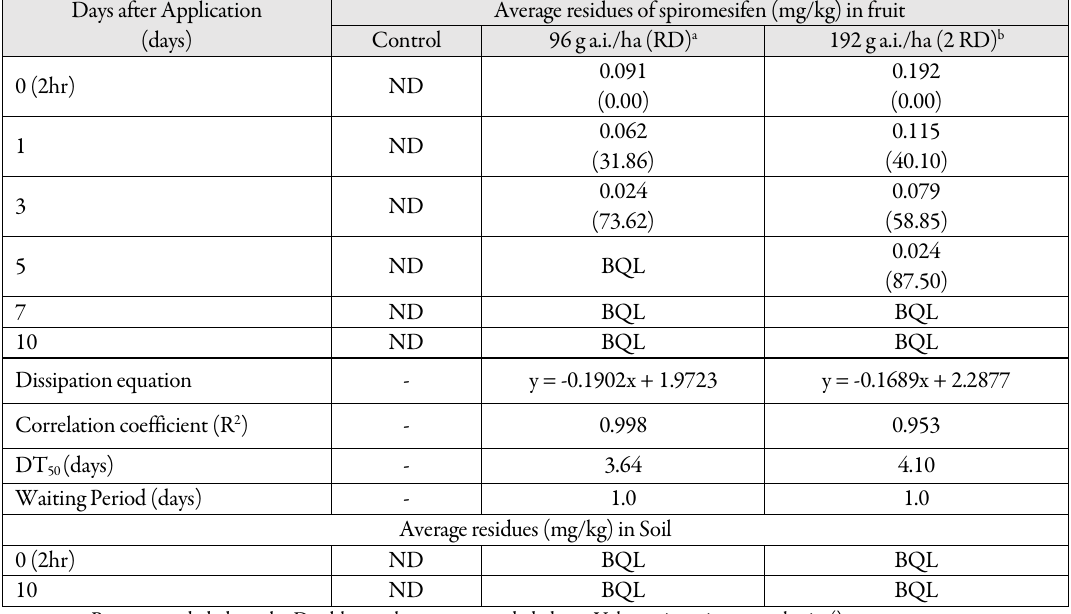
Table 2. Residues and dissipation pattern of spiromesifen in brinjal fruit and soil Days after